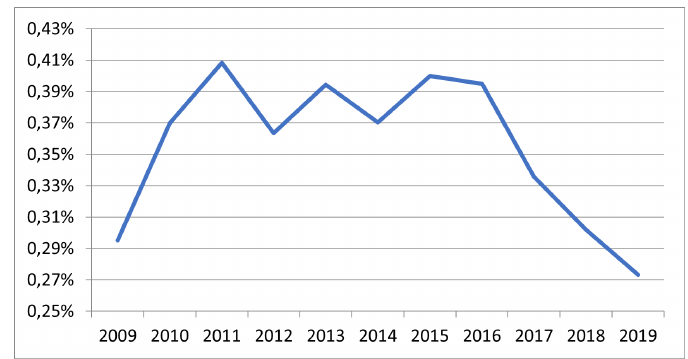
Figure 8: Share of the Veszpr´em District in the National Revenue of the hospitality